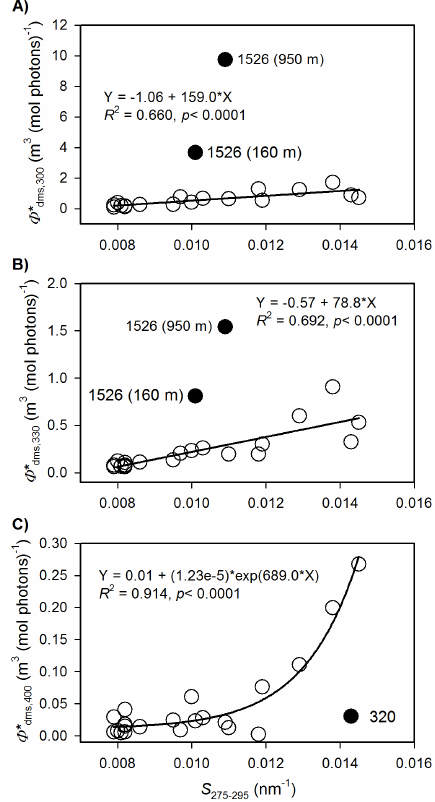
Fig. 5. Scatter plots of DMS photolysis AQY versus CDOM’s spectral slope coefficient (275–295nm) for AQY at 300 (a) , 330 (b) , and 400nm (c) . Solid lines are best fits to the data excluding outliers indicated by filled symbols with station numbers. Spec- tral slope coefficients were non-linearly computed from the model of a cdom ,λ = a cdom ,λ 0 × exp[ S × ( λ 0 - λ) ], where λ 0 is a reference